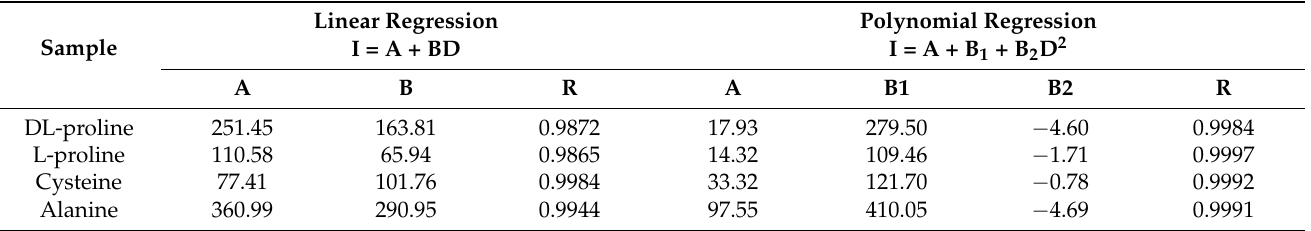
Table 1. Coefficient values for the dependencies of the EPR signal intensity on the applied